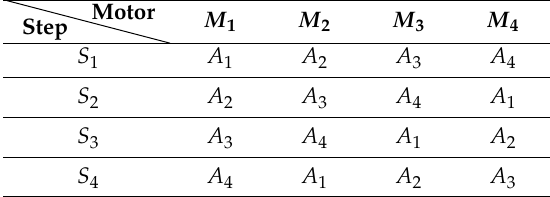
Table 1. Rotation angle of each individual motor for each operational